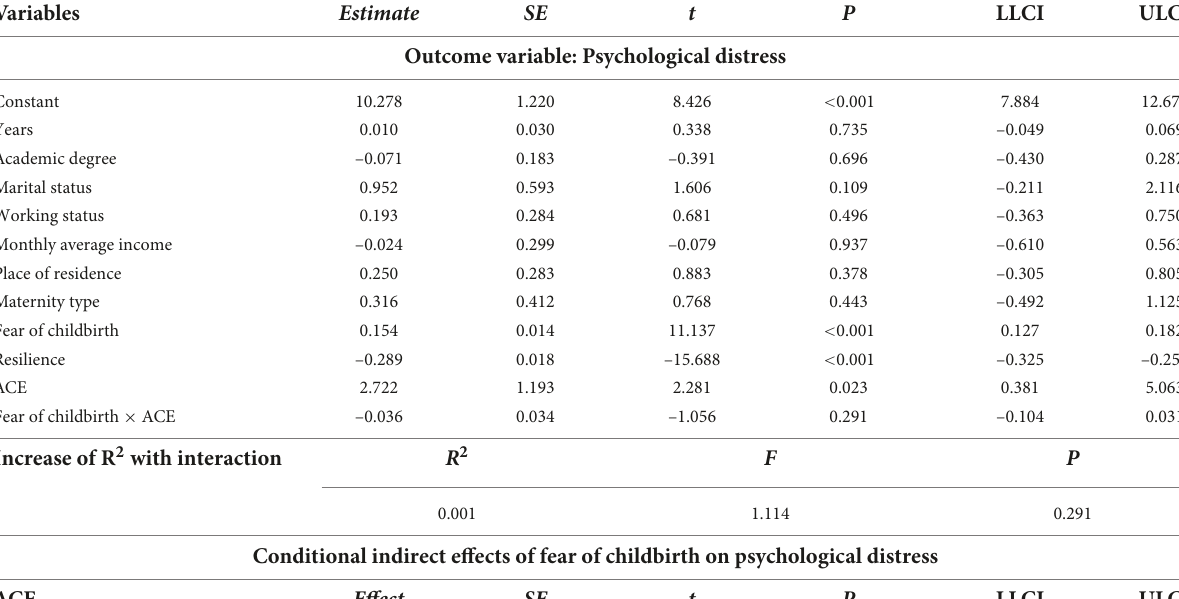
TABLE 4 The moderated effect of ACEs on the association between FOC and psychological distress.